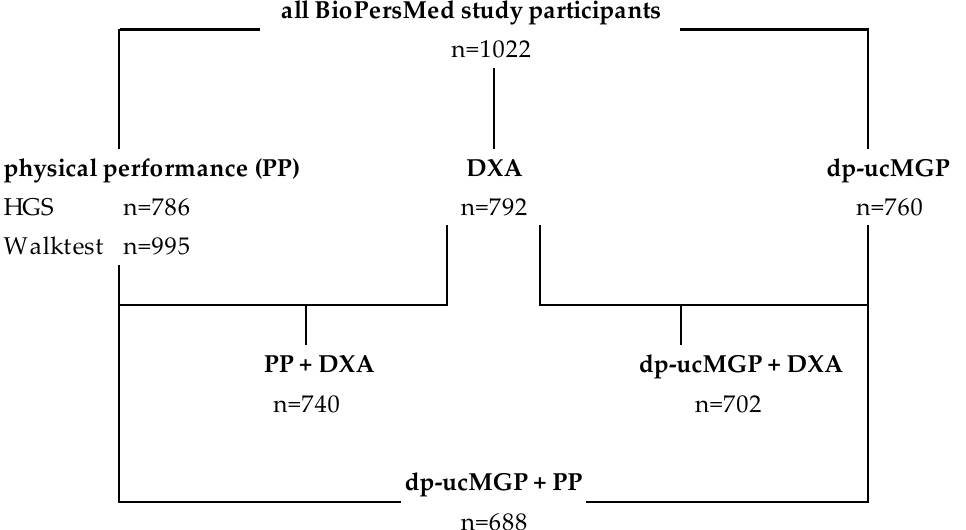
Figure 1. Flow chart of available measurements in the BioPersMed study participants: PP: physical performance; HGS: handgrip strength; DXA: energy X-ray absorptiometry; dp-ucMGP: dephosphorylated, uncarboxylated matrix-GLA-protein; n: number.